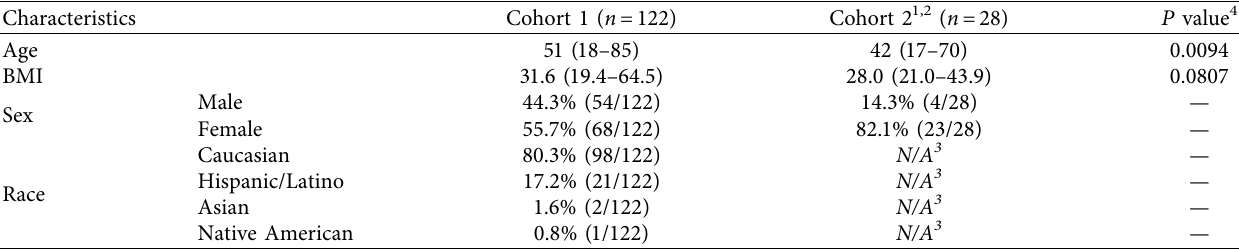
1 Seven individualsdid notreport BMI(body massindex). 2 Oneindividual didnot report sex. 3 Race datawerenot collectedfor this cohort. 4 Unpaired t -test, 2- tailed, α 0.05. (cid:31)